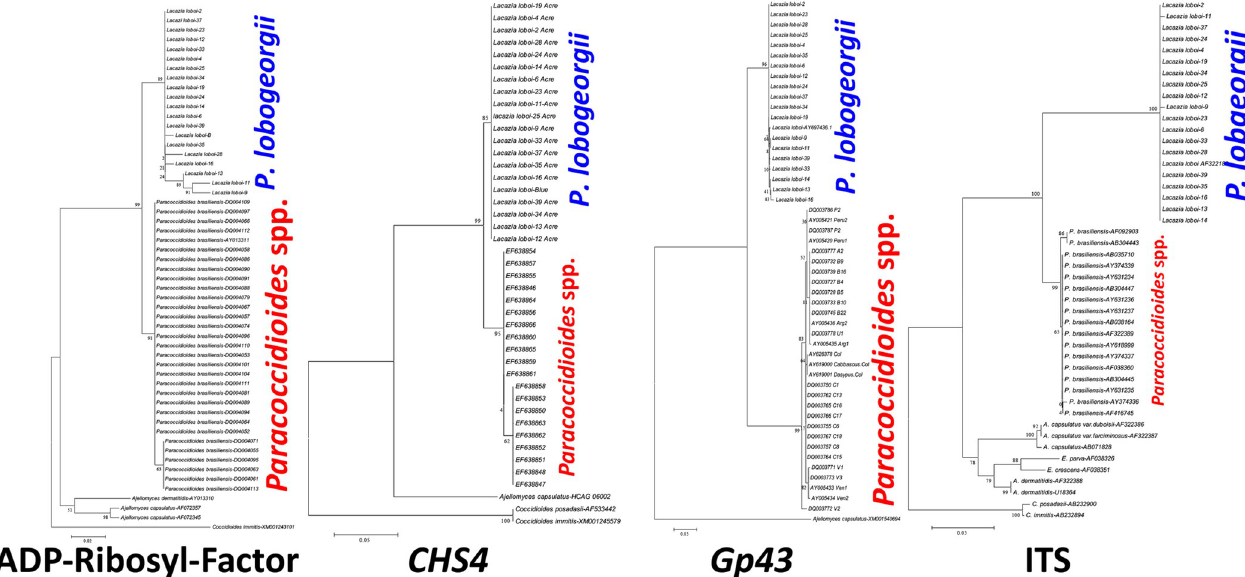
Fig 2. Phylogentic analysis of Paracoccidioides lobogeorgii without P . ceti DNA sequences. Unrooted phylogenetic trees of Paracoccidioides species and P . lobogeorgii ( Lacazia loboi ) without the inclusion of P . ceti . The figure shows the DNA sequences of Paracoccidioides species using ADP-Ribosylation-factor , Chitin synthase 4 ( CHS4 ), Gp43 , Internal Transcriber Spacers (ITS) partial DNA sequences in Maximum Likelihood, and several DNA sequences from dimorphic Onygenales [26]. The figure illustrates the problem faced by earlier investigators conducting phylogenetic analysis without the addition of P . ceti DNA sequences from dolphins with paracoccidioidomycosis ceti. In the phylogenetic trees, the etiologic agent of Jorge Loˆbo’s disease and cultivable Paracoccidioides species are each grouped as independent monophyletic